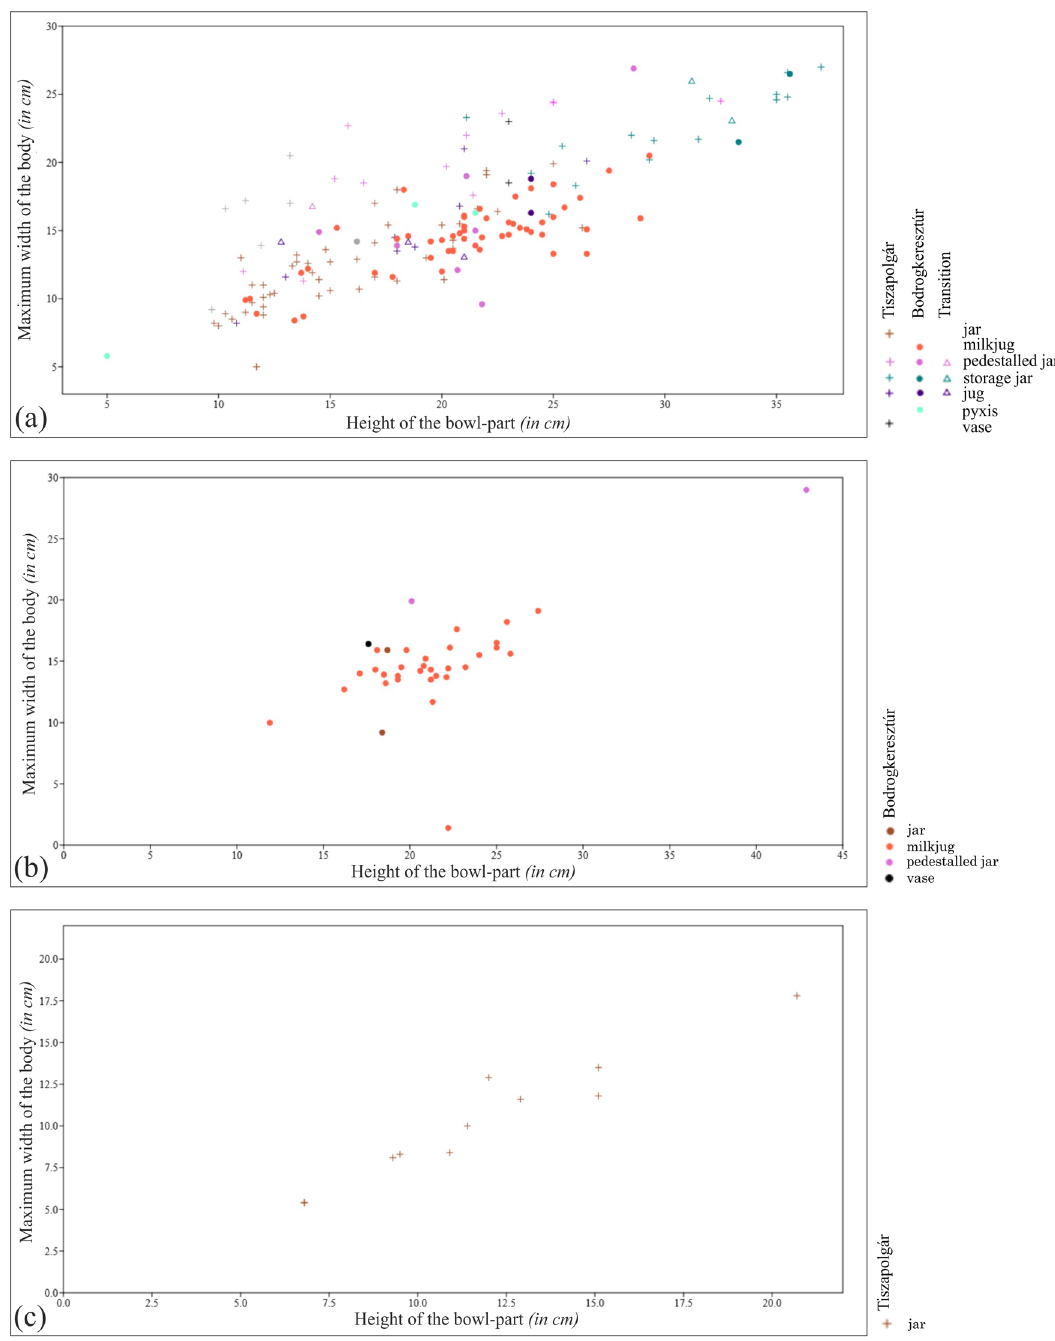
Figure 6: Scatter plot of vessels with neck at: ( a ) Tiszapolgár - Basatanya; ( b ) Tiszavalk - Kenderföld; and ( c ) Polgár - Nagy - Kasziba and Tiszabábolna - Szilpuszta ( the legends contain the traditional typological terms to visualise their metrical distribution )